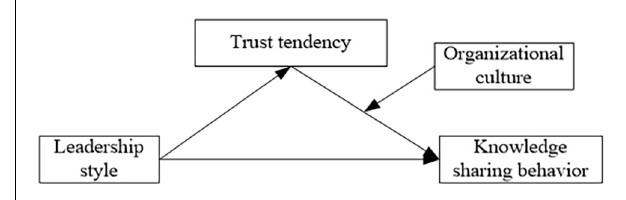
FIGURE 1 | Research